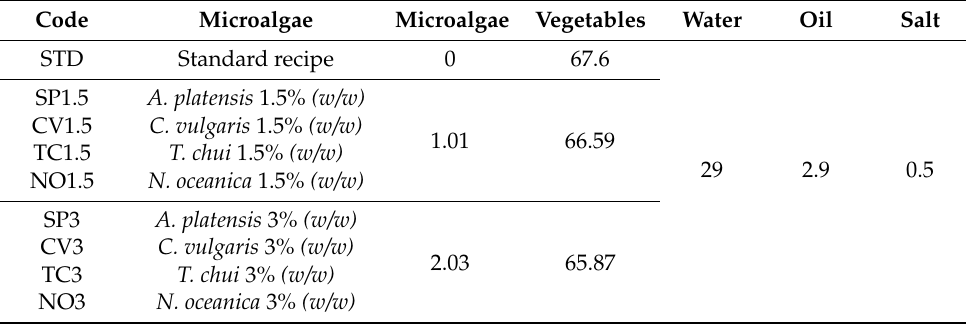
Table 1. Formulation of the vegetable creams containing microalgae (g/100 g). Code Microalgae Microalgae Vegetables Water Oil Salt STD Standard recipe 0 67.6